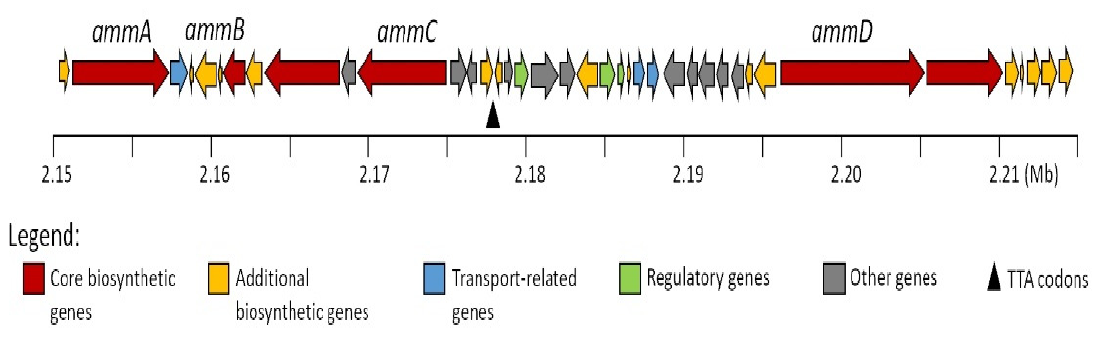
Figure 2. Putative biosynthetic gene clusters (BCGs) Encoding for Amycolatomycins.